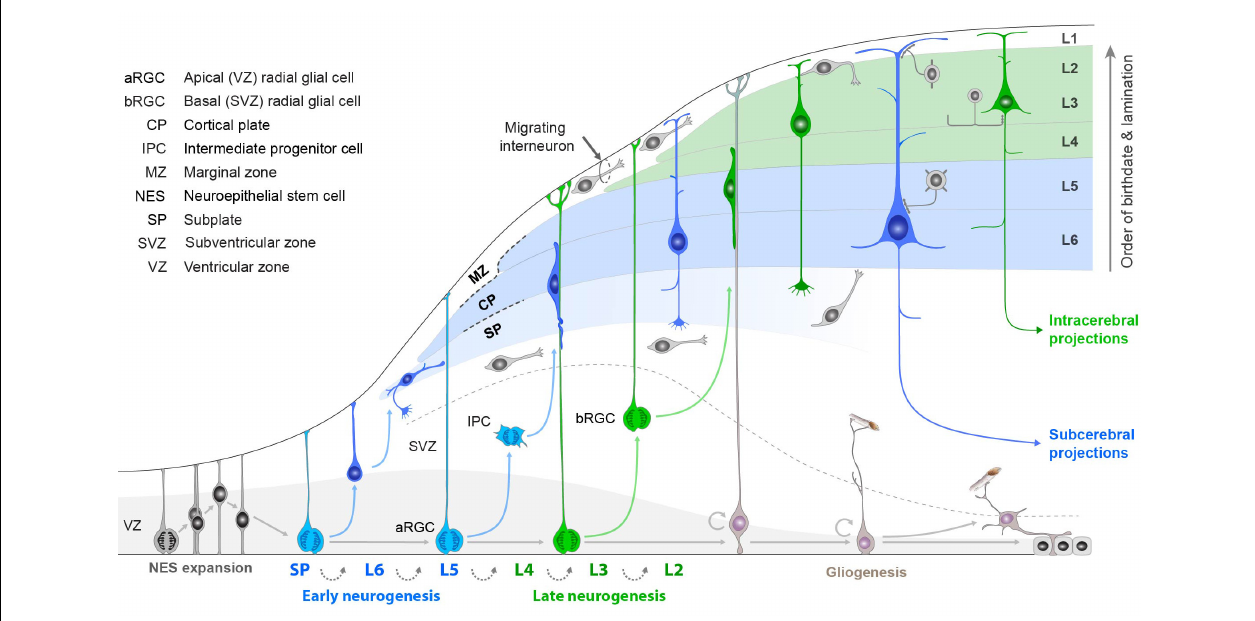
FIGURE 9 | Summary of steps in neurogenesis and differentiation of the main types of neocortical pyramidal cells based on intracerebral (intratelencephalic IT) and subcerebral (pyramidal tract PT, corticothalamic CT) connectivity, as described in the text. Note the consistency of these types with the adult pyramidal cell types